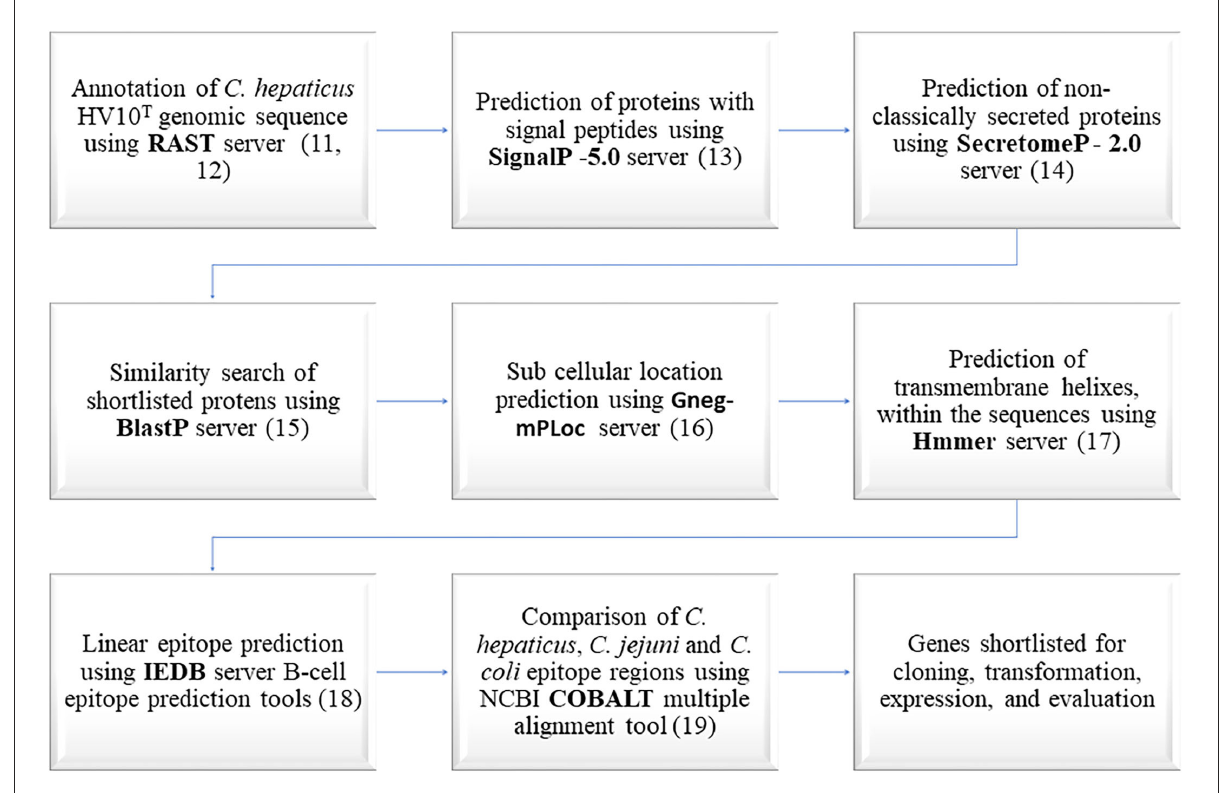
FIGURE1 Bioinformatics workflow used in the prediction of C. hepaticus specific immunogenic